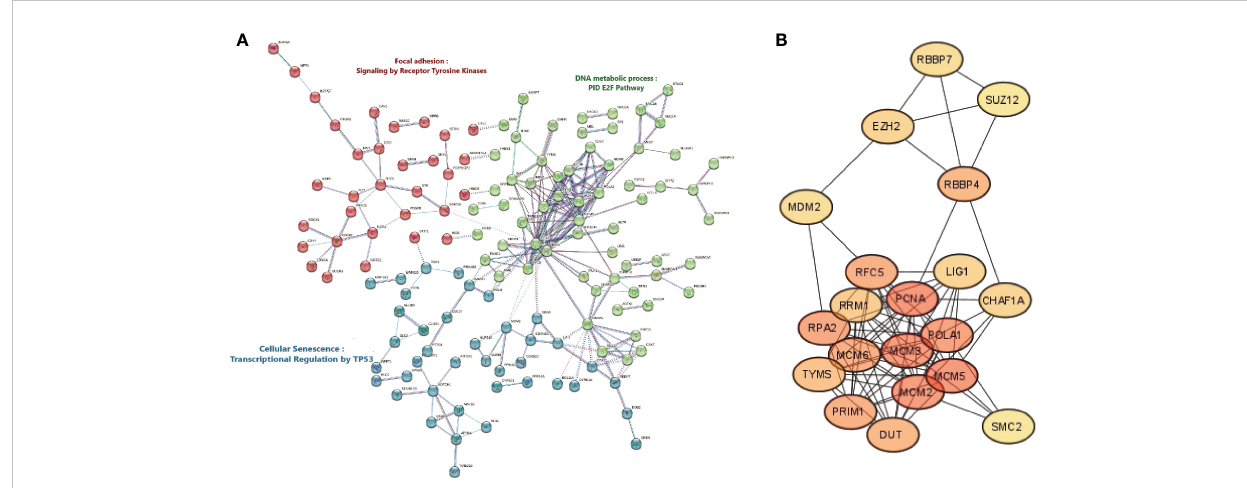
FIGURE 3 Protein-Protein Interactions network, Clustering analysis, and Hub Genes identi fi cation. (A) Cluster analysis of the protein-protein interaction network complex of the differentially expressed genes in HPV + compared to HPV - HNSCC patients using the STRING database. The network is portioned into 3 clusters based on the k-mean clustering algorithm. The solid and the dotted lines indicate a connection inside the same and other clusters, respectively. Different colors of edges indicate the diverse type of protein-protein interaction including Cyan: curated related databases, Pink: experimentally determined, Blue: gene co-occurrence, Black: co-expression, and Light blue: protein homology. (B) Discovering top scoring twenty Hub genes in HNSCC, selected by a topological analysis with Degree method by the CytoHubba in